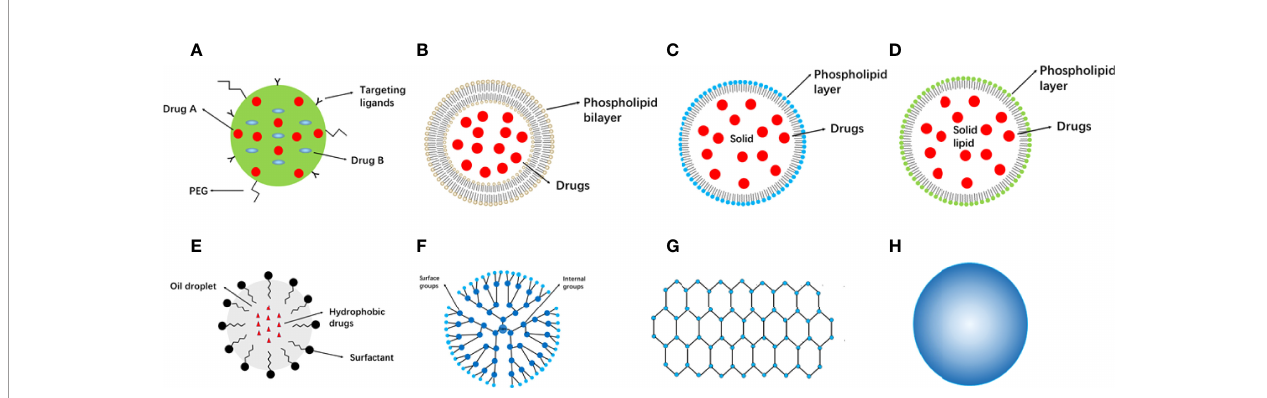
FIGURE 1 | Categories of nanomaterials used in cancer therapy. (A) Nanoparticles. (B) Liposomes. (C) Solid lipid nanoparticles. (D) Nanostructured lipid carriers. (E) Nanoemulsions. (F) Dendrimers. (G) Graphene. (H) Metallic nanoparticles. PEG, poly (ethylene